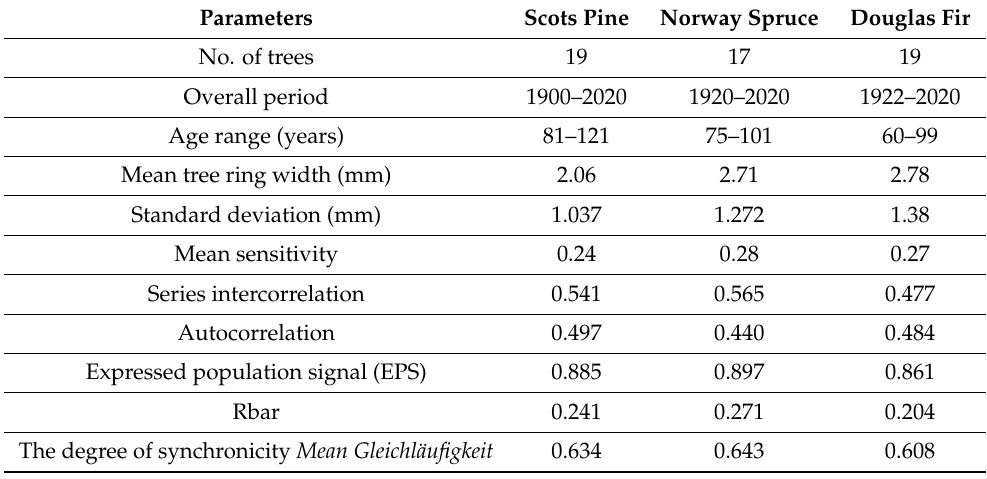
Table 1. Statistical characteristics of tree ring width index chronology of Scots pine ( Pinus sylvestris ), Norway spruce ( Picea abies ), and Douglas fir ( Pseudotsuga menziesii ) Scharbeutz (northern Germany).